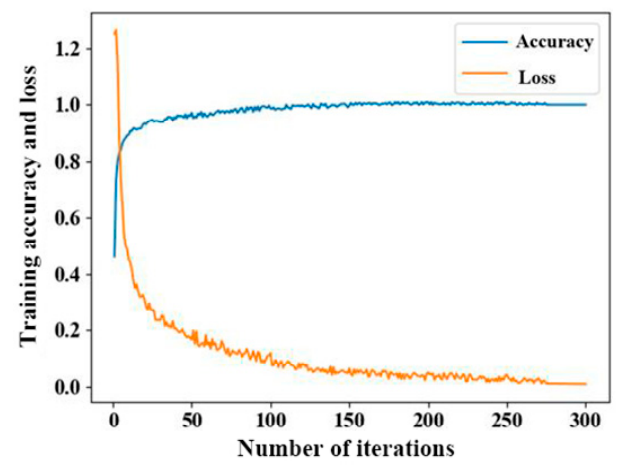
Figure 8. Iterative process of classification model.